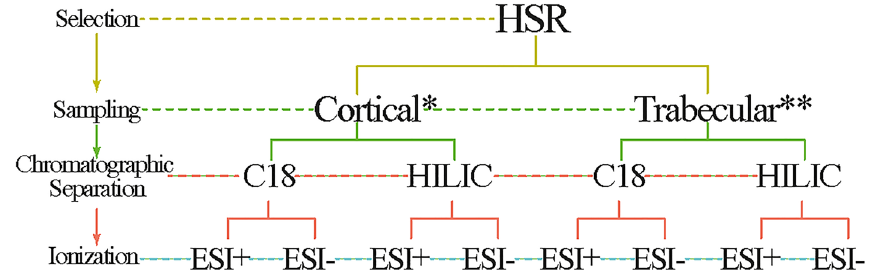
Figure 4. Scheme of the eight experiments performed in human skeletal remains (HRS) to evaluate the differences in skeletal structures by untargeted metabolomic LC-HRMS. *Cortical bone from femur, humerus, tibia. ** Trabecular bone from 1st metatarsals, 2nd metatarsals,